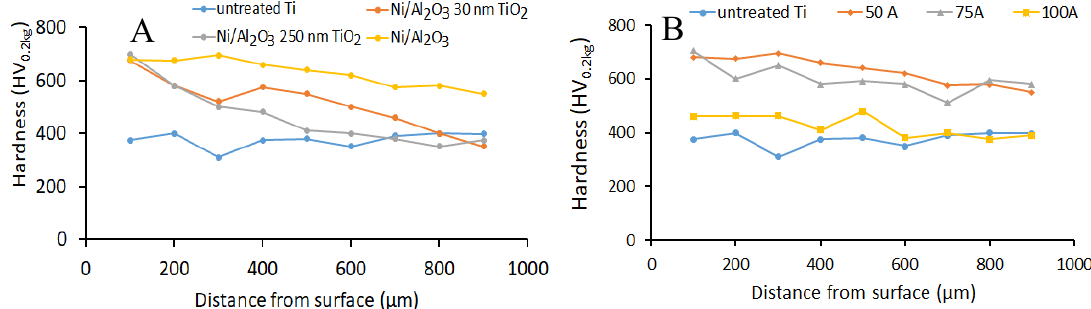
Figure 10. Hardness profile of the surface hardened Ti-6Al-4V alloy ( A ) as a function of coating composition using 75 A welding current. ( B ) As a function of welding current using Ni/Al 2 O 3 co-deposited coating.